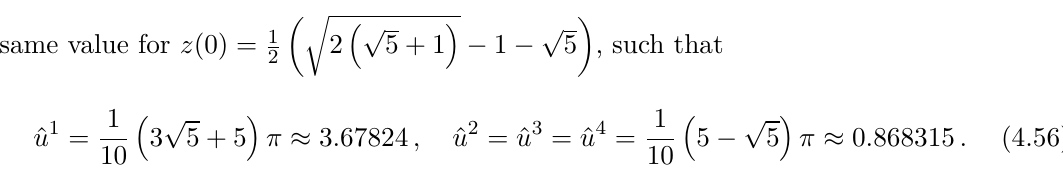
(cid:18)r (cid:19) √ (cid:16) √ (cid:17) 2 5 + 1 − 1 − 5 , such 2